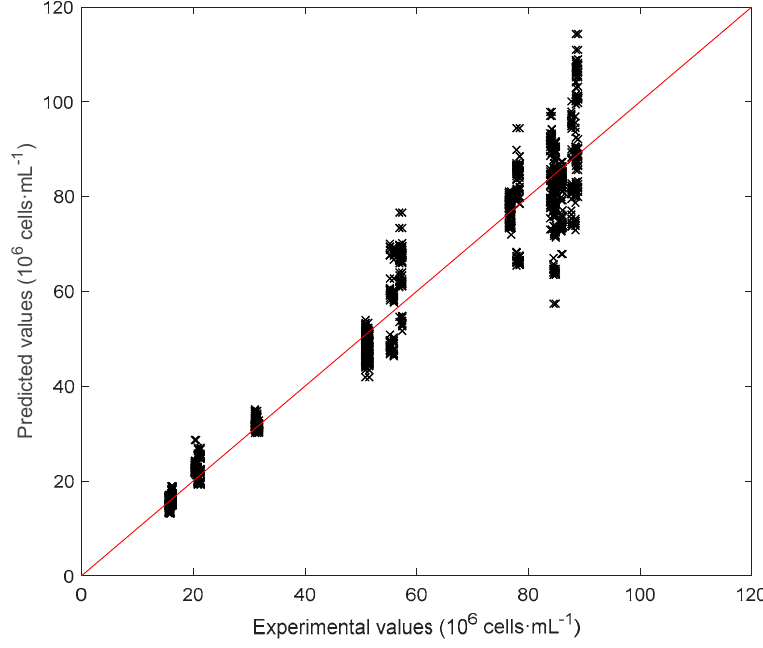
|𝐗 ‖ ln(C x )], SSR = 1.62. Figure 12. Parity plot for model D[ X CI | X FI (cid:107) ln(C x )], SSR = 𝐂𝐈 𝐅𝐈